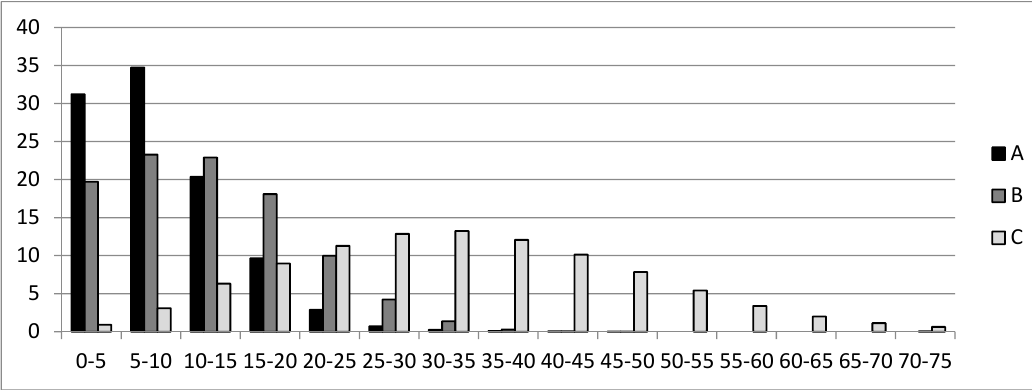
Figure 3. Area distribution for slope classes (% of area vs. slope classes in degrees).